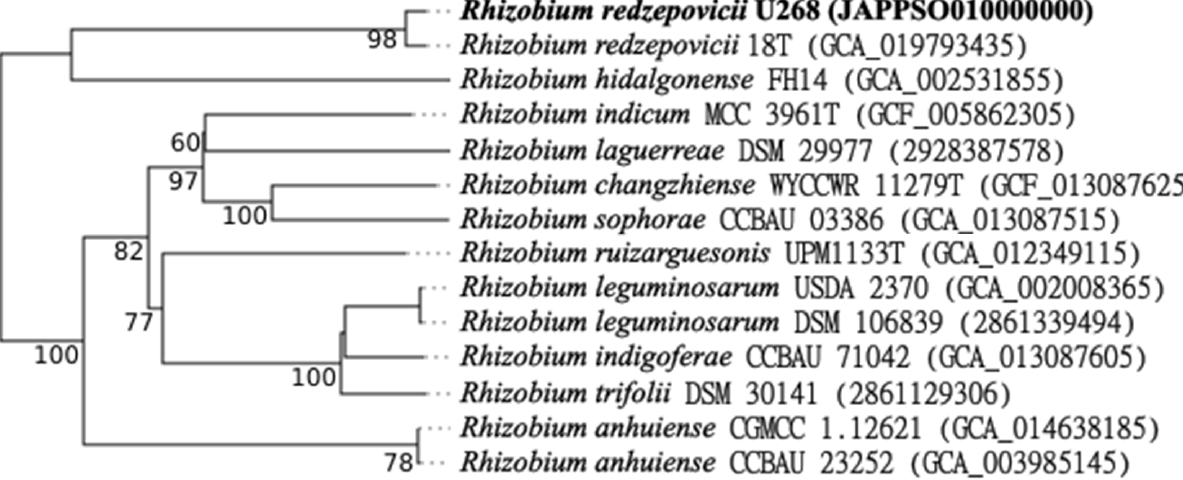
Figure 5. Phylogenetic analysis inferred from Genome Blast Distance Phylogeny (GBDP) distances calculated from genome sequences with TYGS (https://tygs.dsmz.de/, accessed on 7 December 2022). The branch lengths are scaled in terms of GBDP distance. The numbers above branches are GBDP pseudo-bootstrap support values > 60% from 100 replications, with an average branch support of 80.5%. The tree was rooted at the midpoint. The NCBI accession number or the IMG OID (unique numerical identifiers) are shown in brackets. Bold letters indicate the U268 strain.